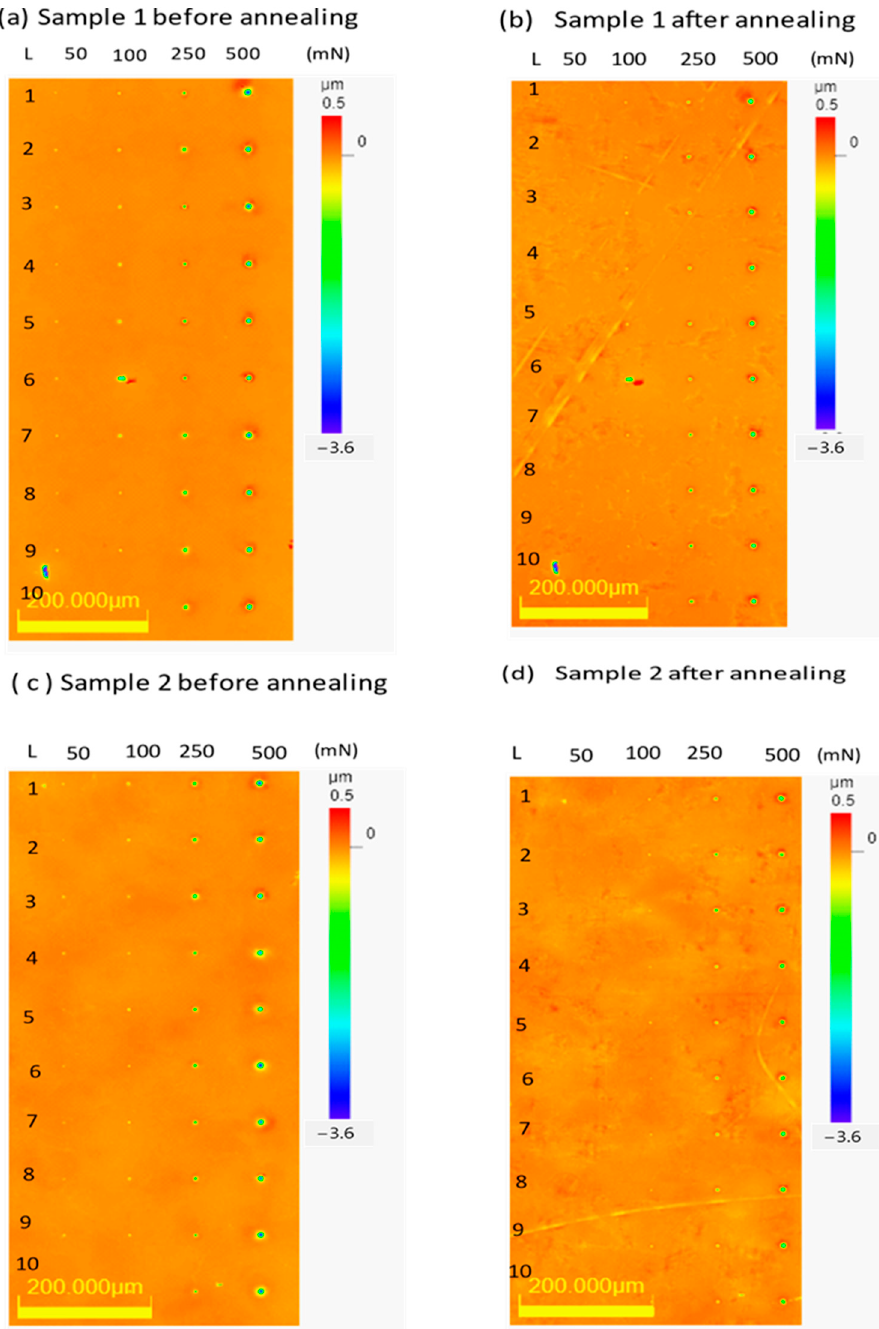
Figure 9. ( a – d ) Microscopic images of samples 1 and 2 before and after annealing in height mode (10 indent points for each load of 50, 100, 250 and 500 mN) with a spherical indenter of radius 5 µ